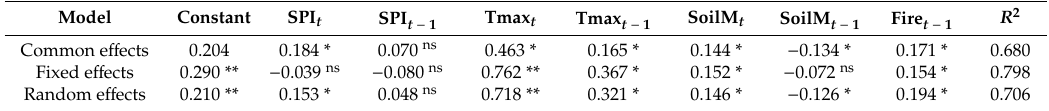
Table 3. Results of panel data models for relationships between the intensity of insect infestation with the intensity of climate hazards of the current year and previous year as well as forest fires of the previous year in NE Iran.